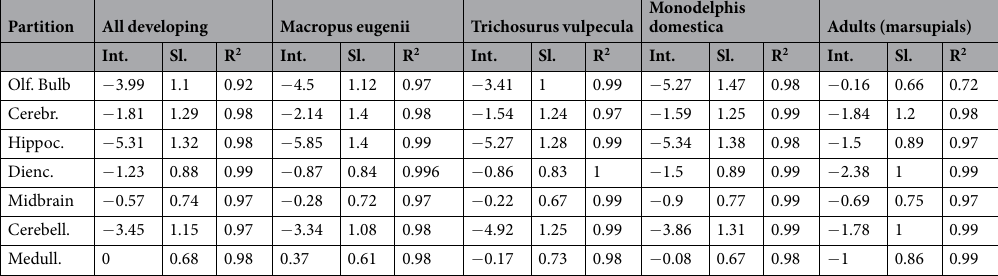
Table 1. Intercepts, slopes, R 2 and significance values of linear regressions of log partition sizes vs. whole brain volume minus partition sizes. All regressions are significant at p <